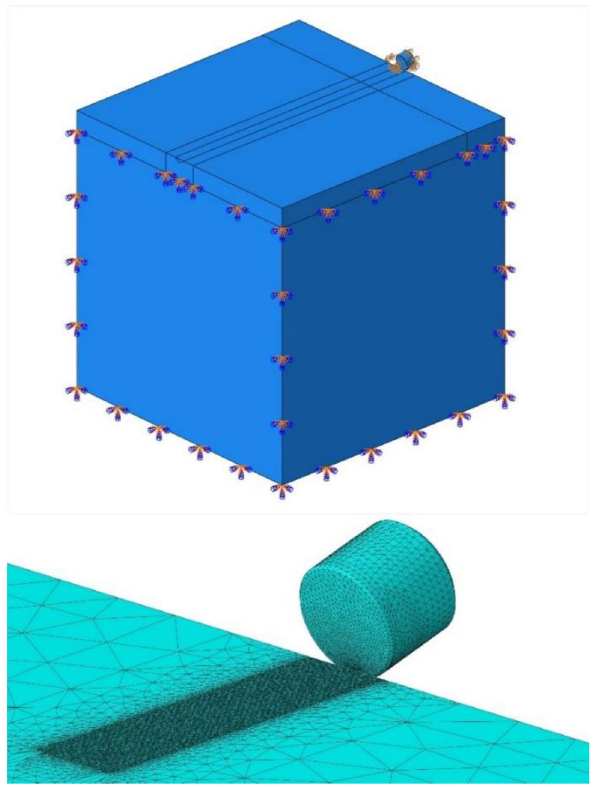
Fig. 6 Model of the cutter scraping shale